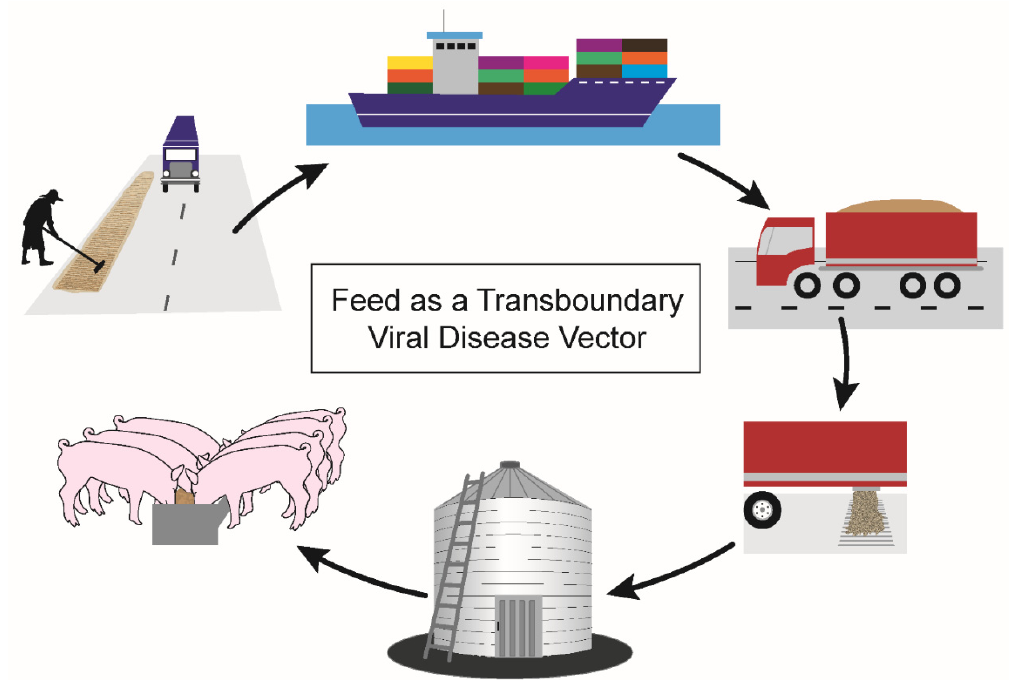
Figure 2. Mechanism by which feed ingredients may serve as transboundary vectors of swine viral diseases. Risky agri- cultural practices, such as drying grains on roadways, may contaminate feed ingredients in countries with circulating diseases. Risky agricultural practices, such as drying grains on roadways, may contaminate feed foreign animal diseases. Trucks carrying pigs may drive over areas where feed ingredients are drying, transferring viruses ingredients in countries with circulating foreign animal diseases. Trucks carrying pigs may drive over through pig excretions and secretions. Feed ingredients are transported in shipping containers across transoceanic condi- areas where feed ingredients are drying, transferring viruses through pig excretions and tions to arrive in the importing country. Trucks transport the feed ingredients on interstate highways to feed mills, where they are incorporated into a complete feed diet. Feed mills widely distribute feed to swine farms for pigs’ consumption and growth.